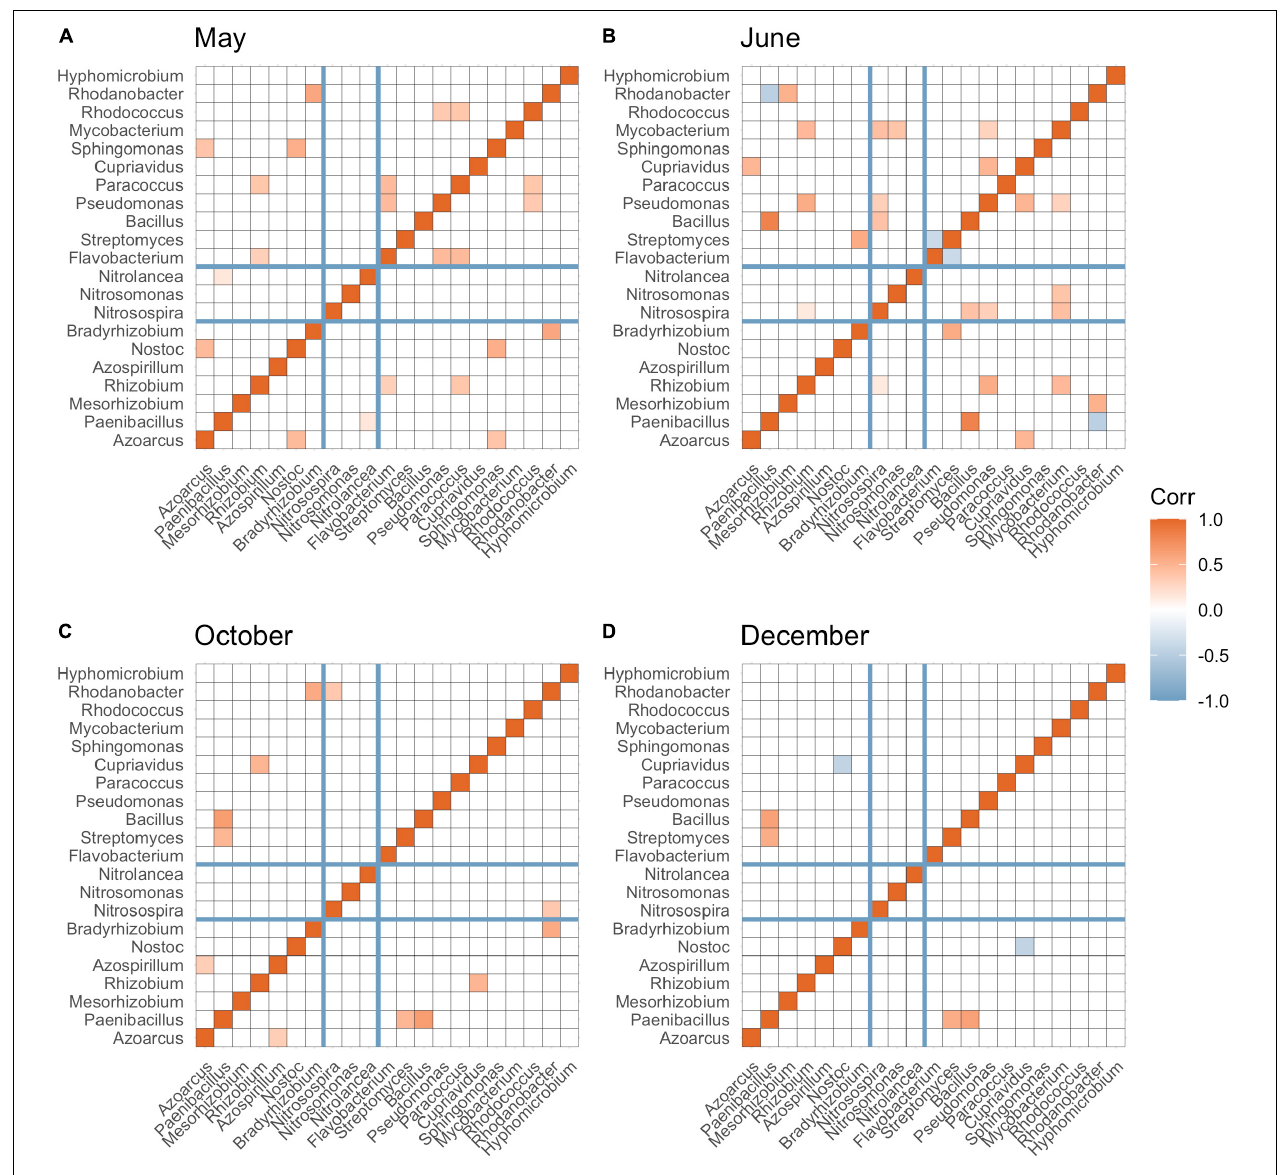
FIGURE 4 | Spearman’s correlation among bacterial taxa at the genus level involved in N-fixation ( Azoarcus to Bradyrhizobium ), nitrification ( Nitrosospira to Nitrolancea ), and denitrification ( Flavobacterium to Hyphomicrobium ) across May (A) , June (B) , October (C) , and December (D) . Significant correlations ( p -adjusted < 0.05) were colored by red (positive correlation) and blue (negative correlation). The darker the color, the greater absolute value of correlation coefficient. False discovery rate was controlled using Benjamini (1995)